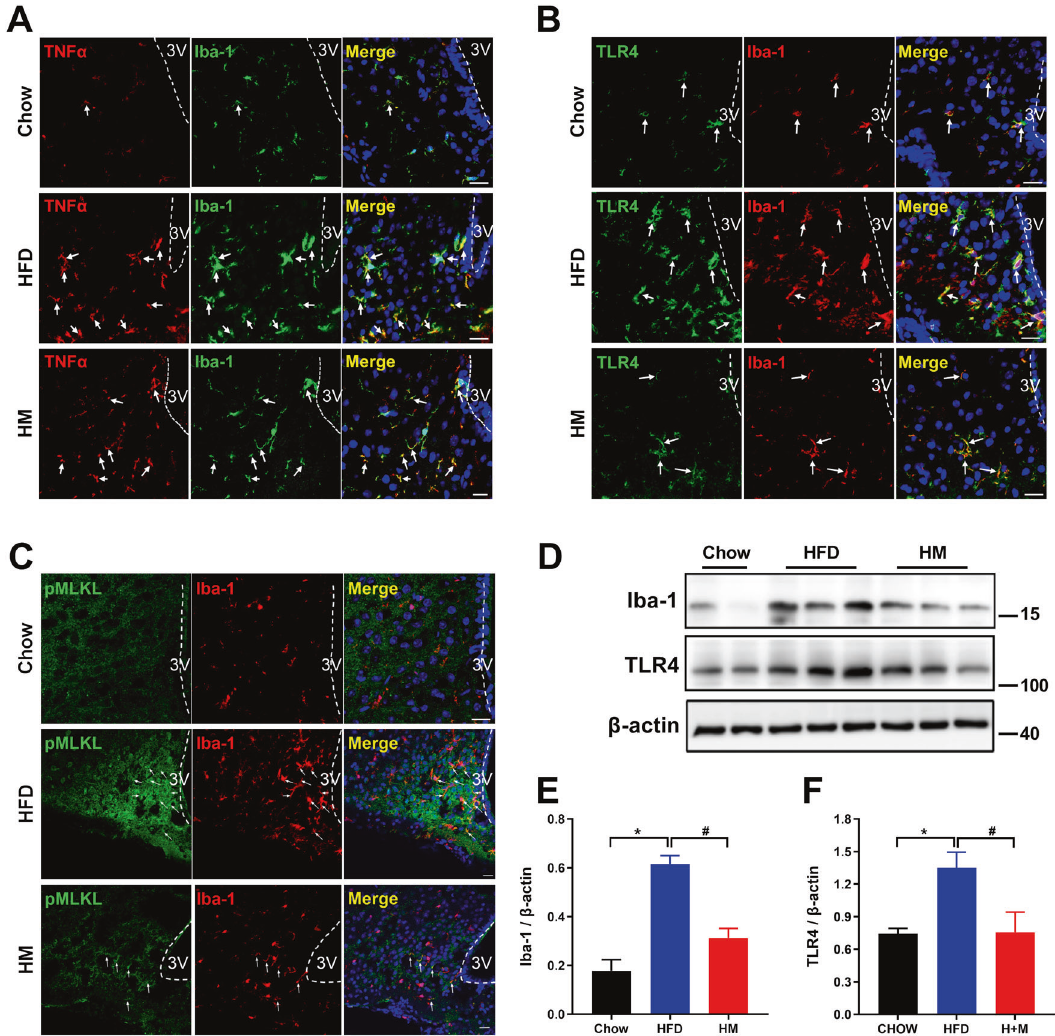
Fig. 3 Metformin reduced microgliosis by suppressing necroptotic microglia in the MBH of DIO mice. A Immunostaining for TNF- α (red) and Iba-1 (green, a marker of activated microglia) in the MBH showed that chronic HFD feeding induced Iba-1 positive microglia accumulation and strong TNF- α immunoreactivity within the area of microglia. Metformin remarkedly decrease the microgliosis and TNF- α positive staining overlapped with Iba-1, indicating metformin downregulated microglial in fl ammation effectively. B Immuno fl uorescent staining for TLR4 (green) and Iba-1 (red) in the MBH indicated that TLR4 expression was observed on the surface of Iba-1 positive microglia in HFD mice and that HM mice exerted a reduced amount of microglia and corresponding decreased TLR4 staining. C Immuno fl uorescent double-staining for p-MLKL (green) and Iba-1 (red) in the MBH. Iba-1 immunoreactivity was co-localized with pMLKL immunoreactivity, demonstrating microglia underwent necroptosis caused by chronic HFD feeding. Metformin treatment markedly repressed microglial necroptosis in HM mice ( n = 4). White arrows indicated the merge of the two colors. Scale bar represented 20 μ m. D , E , F Immunoblotting data for Iba-1 and TLR4 expression. The data were presented as mean ± SEM. * P < 0.05 vs. Chow mice; # P < 0.05 vs. HFD